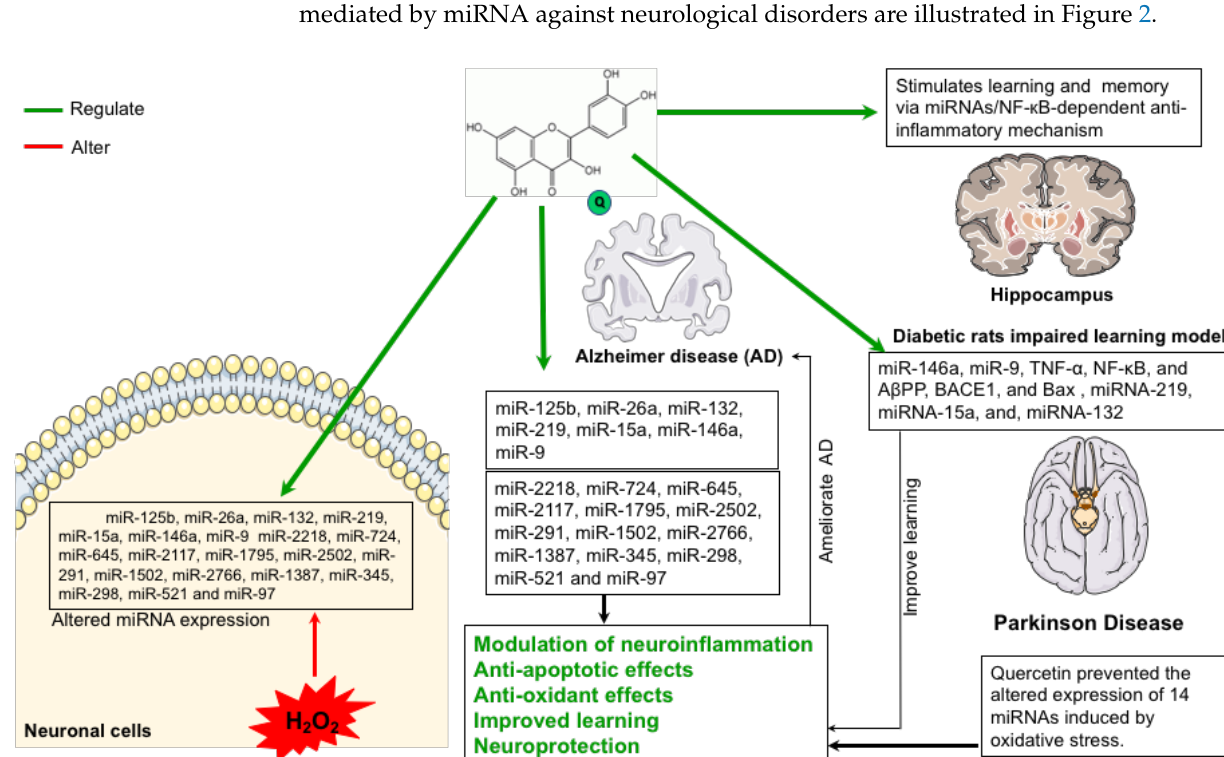
Figure 2. Neuroprotective and antioxidant effects of quercetin mediated by miRNA against neurological disorders. Quercetin prevents the altered expression of a number of miRNAs induced by oxidative stress in neuronal cells and PD model. Quercetin regulates miRNAs expression potentially involved in AD progress and normalized the genes and miRNAs expression in the hippocampus of diabetic rats in an impaired learning